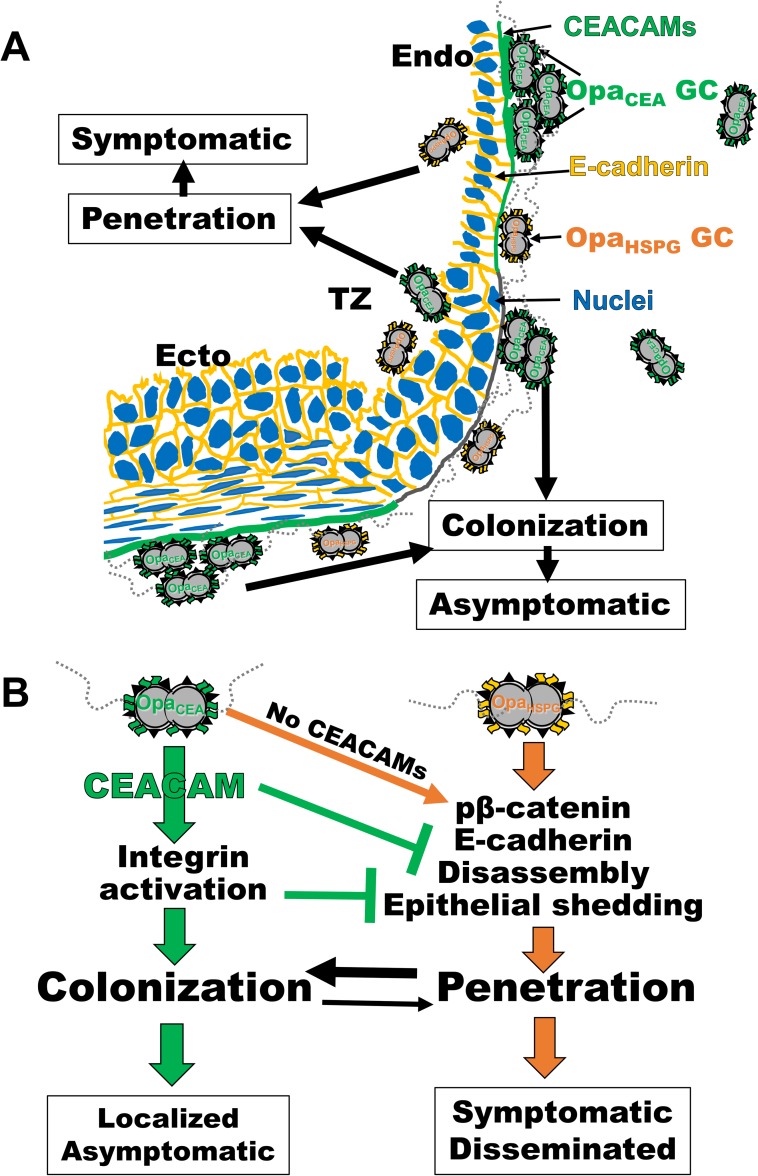
Both the heterogeneous properties of cervical epithelial cells and the surface molecules of GC regulate GC infectivity.The results of this study and numerous published studies enable us to propose a working model for GC pathogenesis in the FRT. (A) GC delivered into the vagina establish efficient and persistent colonization at the ectocervix and probably also at the TZ and endocervix through pili and evolution-driven expression of OpaCEA, which leads to asymptomatic local infections. GC can take advantage of the low CEACAM expression in the TZ to penetrate the epithelium, leading to cervicitis. Low expression of OpaCEA allows GC to effectively penetrate into the endocervical epithelium, potentially causing symptomatic infection. (B) GC penetrate the epithelia of the endocervix and TZ by inducing the phosphorylation of β-catenin, which leads to the disassembly of E-cad-based epithelial cell-cell junctions and epithelial exfoliation. Opa-CEACAM interaction drives GC infectivity into the colonization mode while inhibiting the penetration mode, by blocking β-catenin phosphorylation and epithelial cell-cell junction disassembly and activating integrin-mediated epithelial adhesion, which reduce the shedding of GC-associated epithelial cells. Because GC with low levels of OpaCEA expression are rare, as most 11 Opa proteins are OpaCEA, the majority of the bacteria colonize rather than penetrate the cervical epithelium, explaining why most infections of the FRT are asymptomatic and the invasive disease is rare.